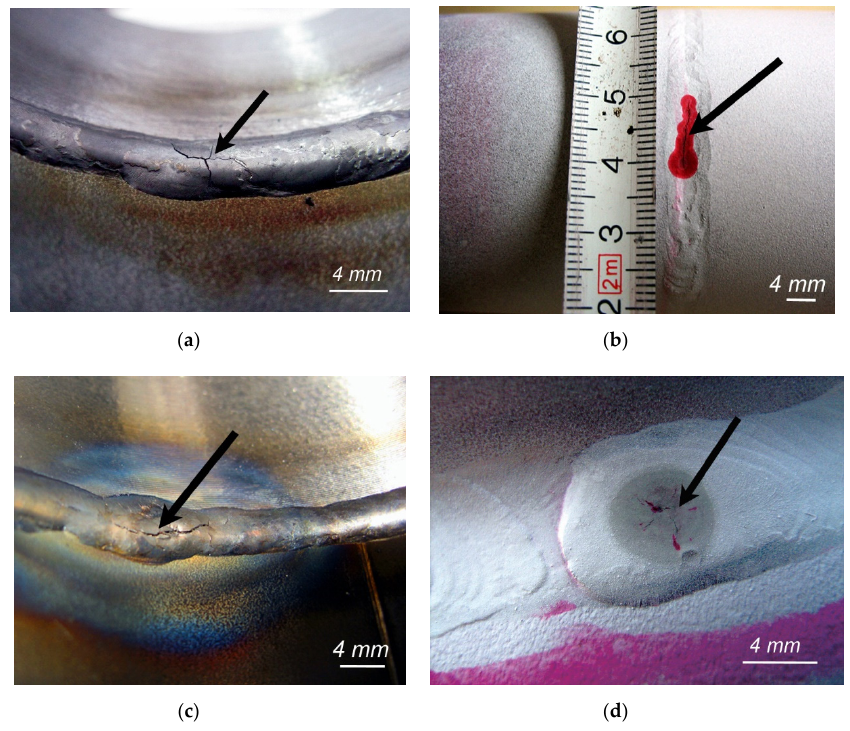
Figure 2. Examples of welding imperfections identified after the preliminary welding tests ( a ) and ( c ) crack form the root; ( b ) and ( d ) cracks from the face. The arrows mark the cracks.